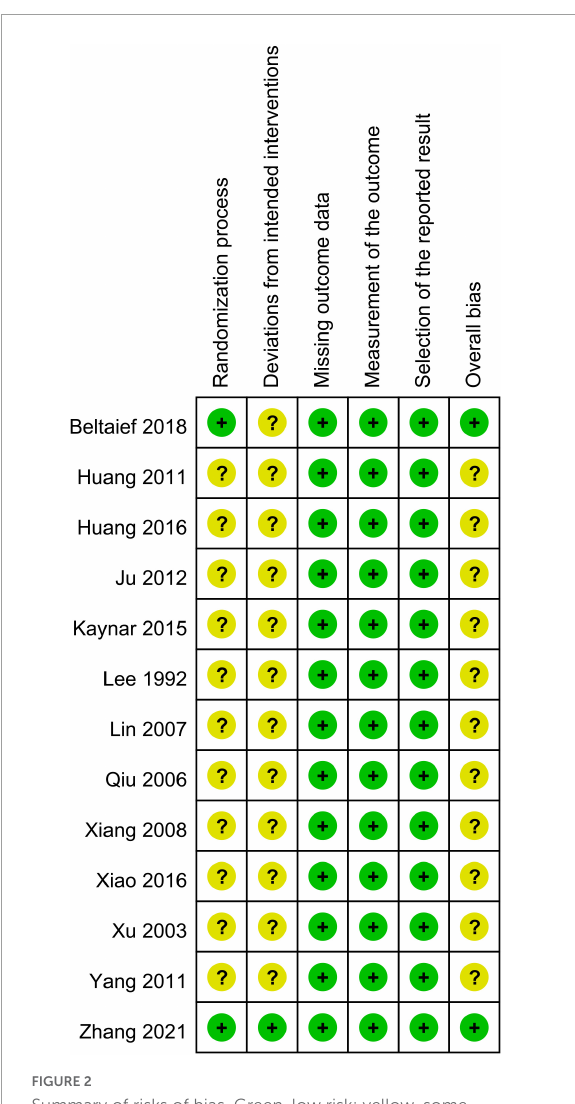
FIGURE2 Summary of risks of bias. Green, low risk; yellow, some concerns.